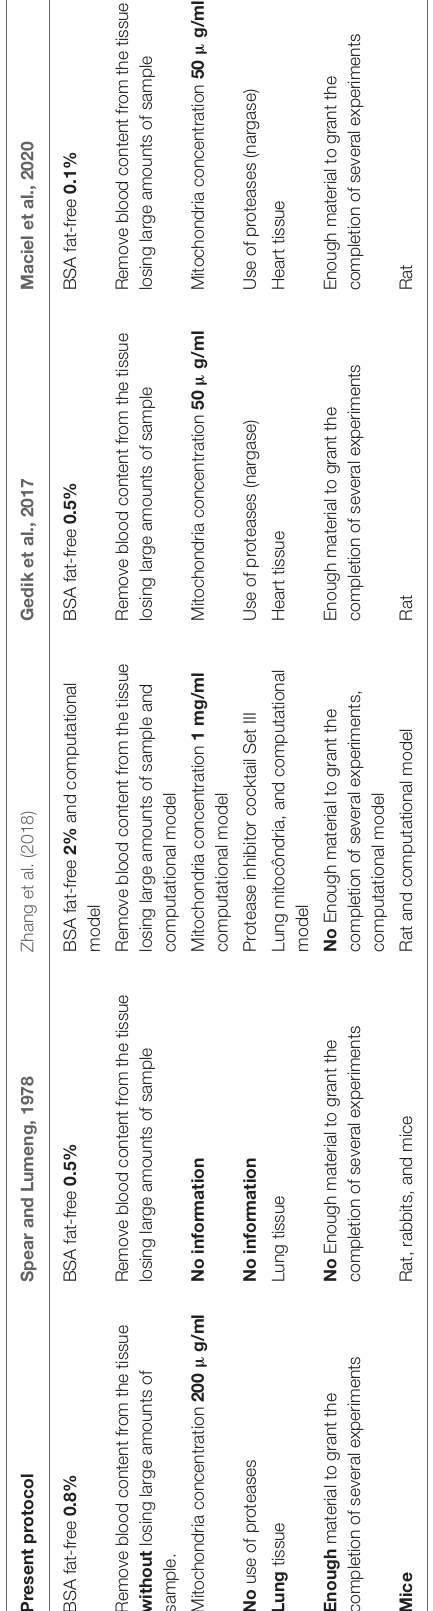
maximum), and lung mitochondria-200 µ g (81.84 ± 15.35% maximum) did not differ among them ( p = 0.3), as depicted in Figure 4C